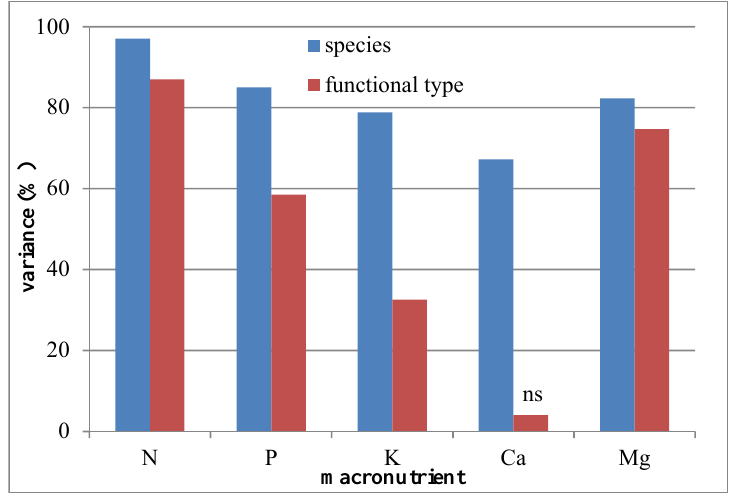
Figure 4. Amount of variance explained by species and functional type in foliar macronutrient concentration. ns indicates insignificant difference ( p >